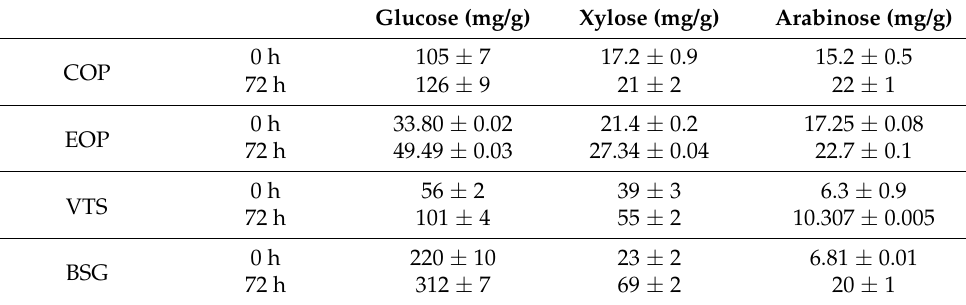
Table 1. Sugars released by enzymatic treatment of